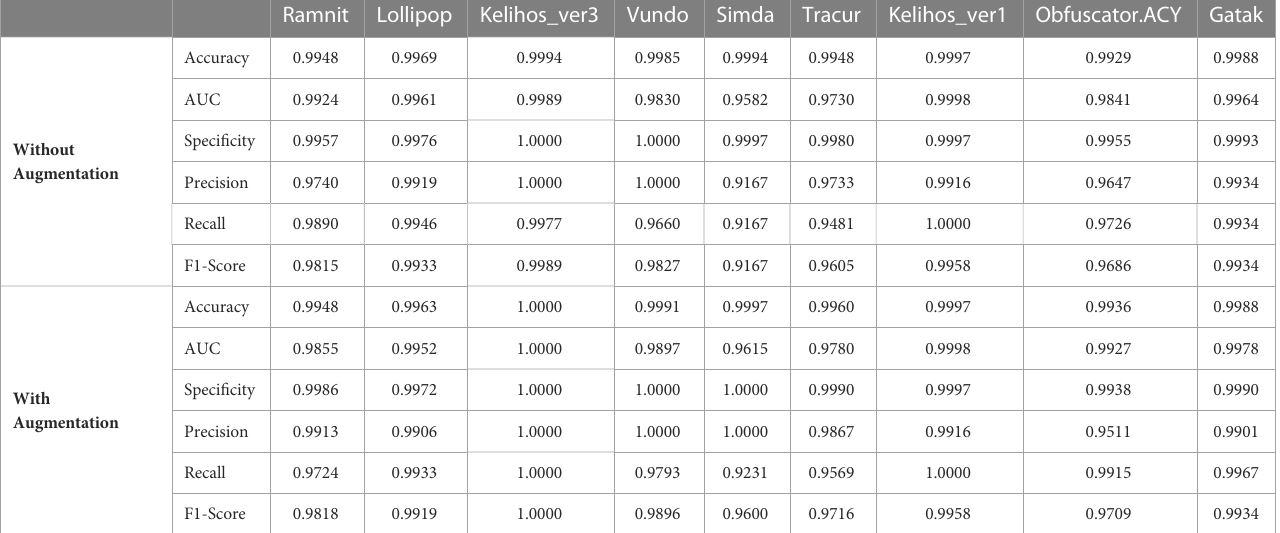
TABLE 4 Experimental results of RGB images converted from BIG2015